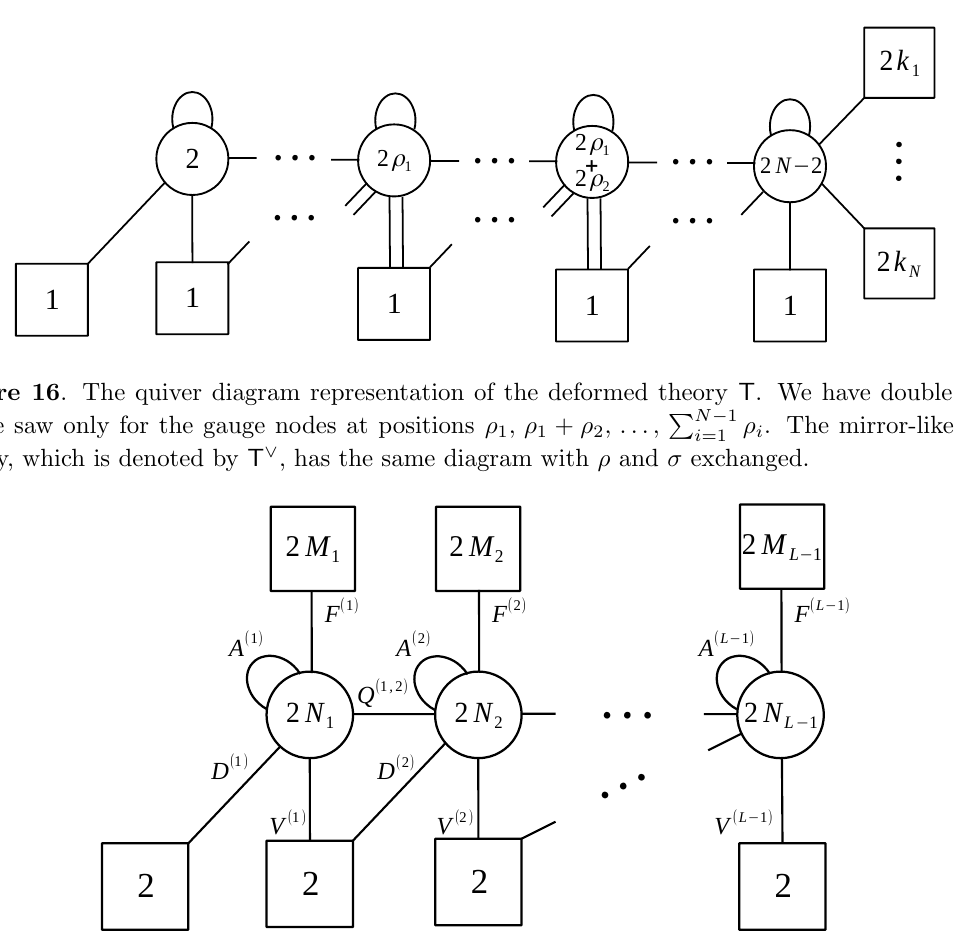
Figure 17 . The E (cid:27) [USp(2 N )] quiver diagram. To avoid cluttering the drawing the gauge singlet (cid:26) (cid:13) nj and (cid:25) ( i;j ) are not shown in this diagram. rename as Q ; ~ Q the massless chirals at the USp(2( N (cid:0) 1)) gauge node in the funda- m m mental representation of each USp(2 k ) factor, with m = 1 ; (cid:1) (cid:1) (cid:1) ; N . In particular, for the m values of m for which k = 0 we don’t have any chiral (cid:12)eld. Their interaction with the m antysymmetric A ( N (cid:0) 1)